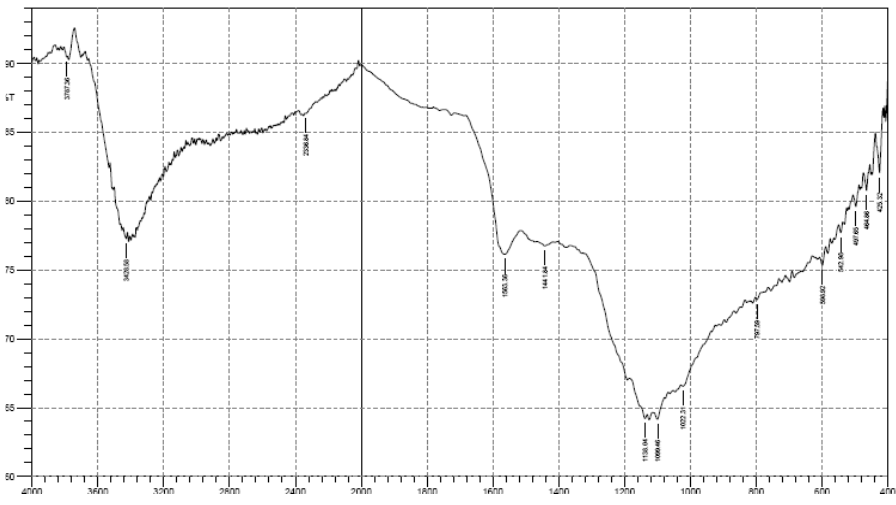
Figure 4. FT-IR Spectrum of